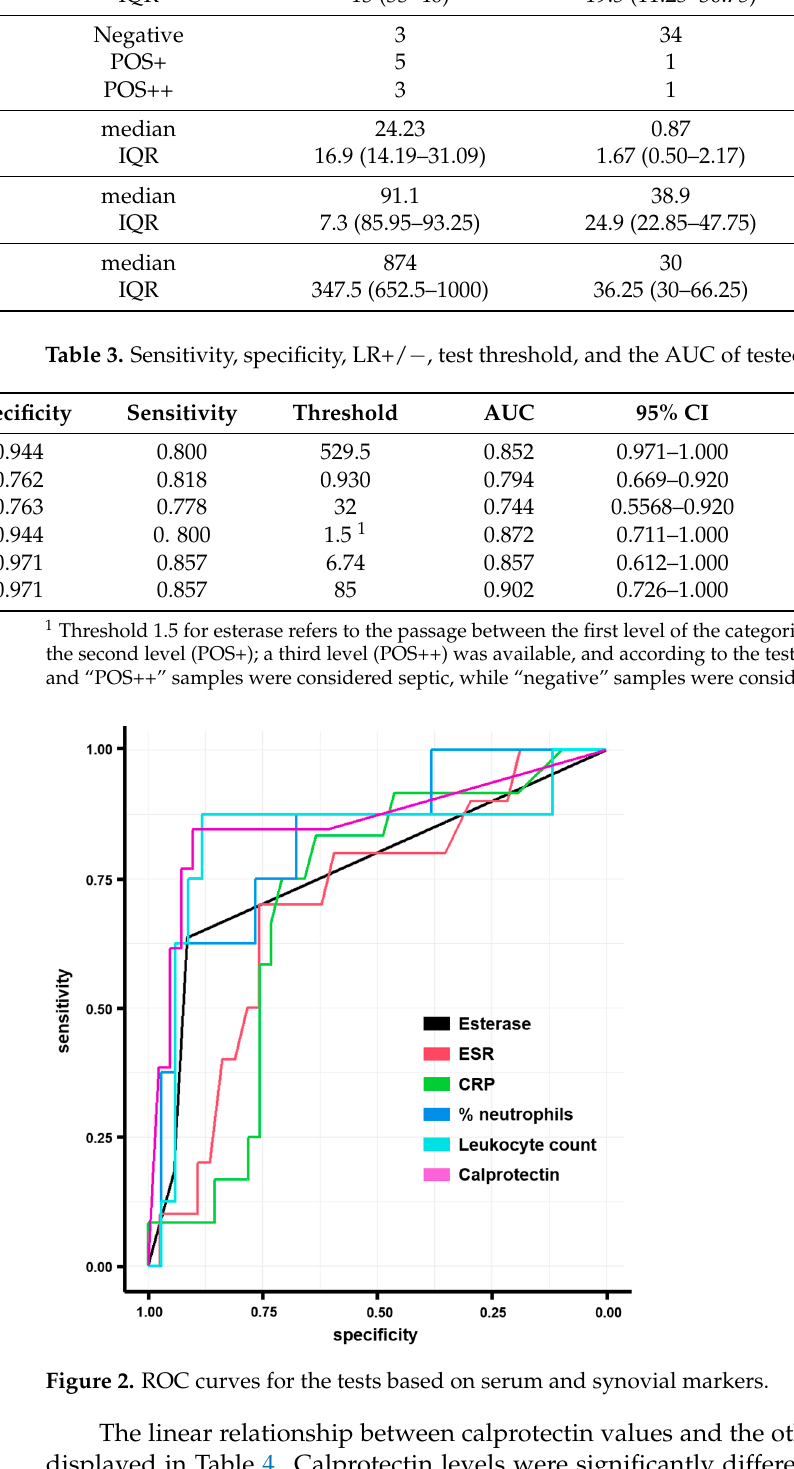
- Figure 3. Calprotectin levels distribution in subjects with different results at the esterase test. POS+ and POS++ patients showed significantly higher levels of calprotectin compared to negative sub- jects. * p < 0.05 vs. negative subjects.